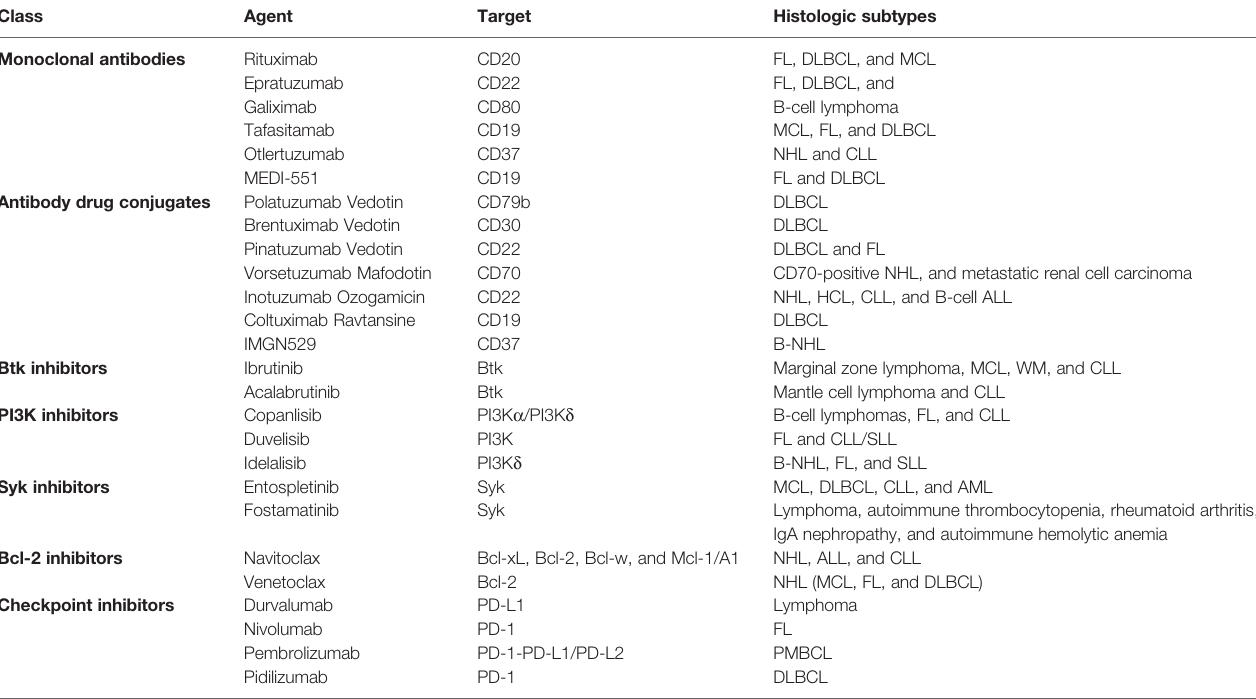
TABLE 1 | Immunotherapeutic approaches for B-Cell Non-Hodgkin ’ s